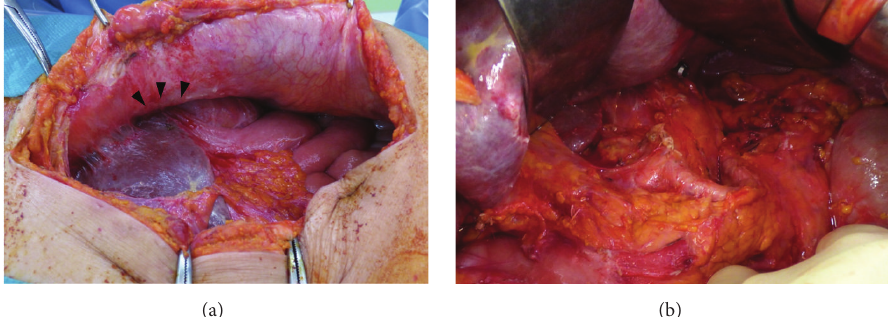
Figure 4: (a) The tightest adhesion (black arrowhead) between the lateral segment of the liver and the lesser curvature of the gastric remnant due to previous surgery and the perforation. (b) Curative gastrectomy with D2 lymphadenectomy was performed.